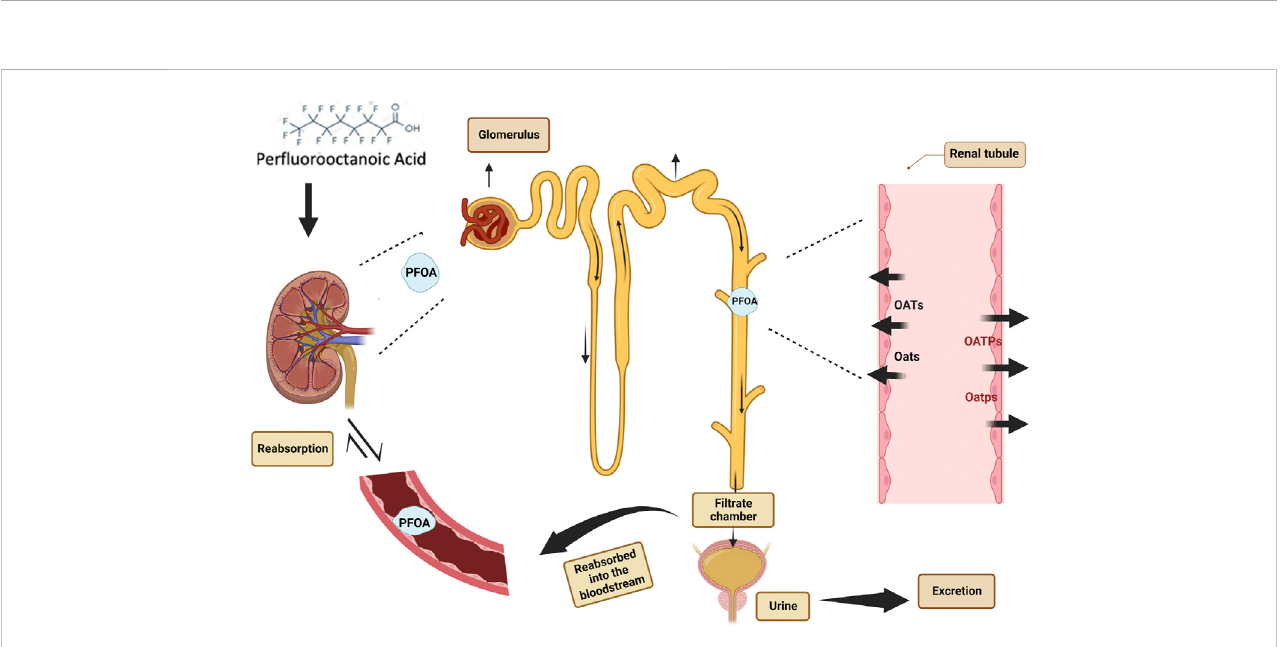
Difference of renal elimination in half life of per fl uorooctanoic